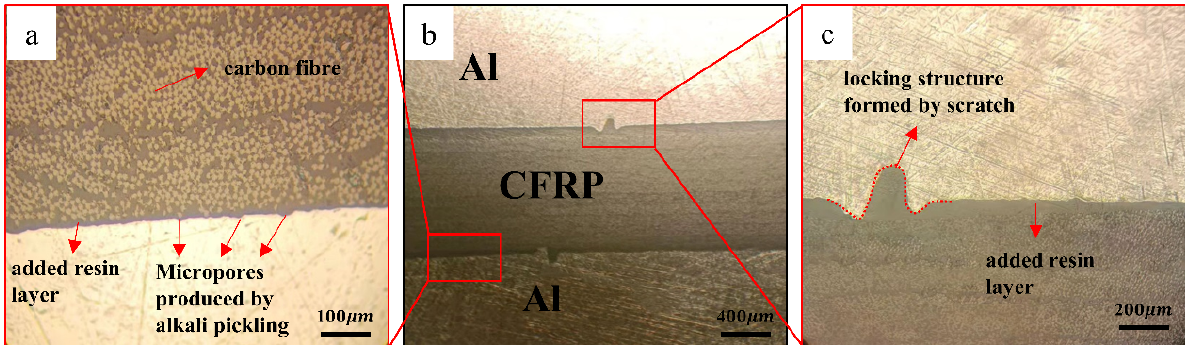
Figure 6. Microstructure of laminate B intercalation and nick.